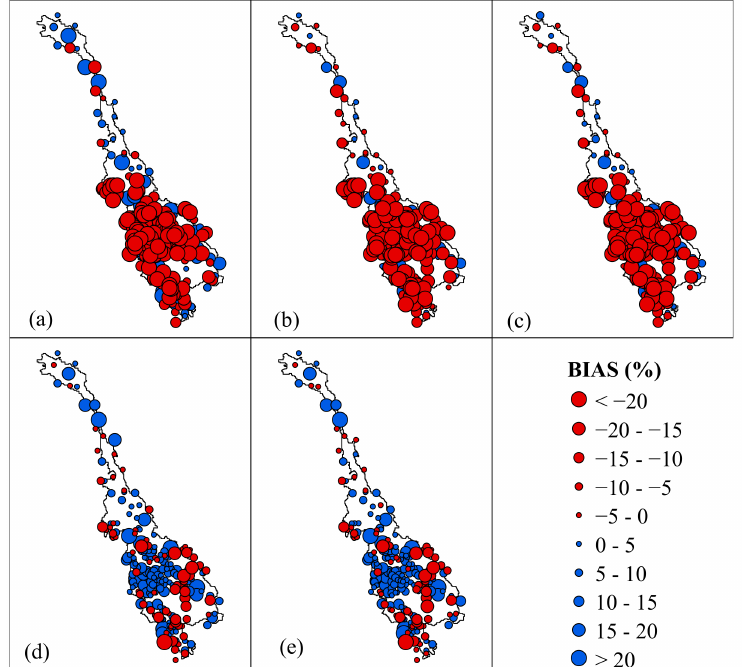
Figure 12. BIAS of MSWEP ( a ), MSWEP-QM ( b ), MSWEP-LS ( c ) compared with gauge observations from 1979 to 1997 and 2008 to 2014 at daily scale; the second line shows the change in BIAS between MSWEP-QM ( d ), MSWEP-LS ( e ), and MSWEP, in which the blue points mean BIAS decreased, and red means the